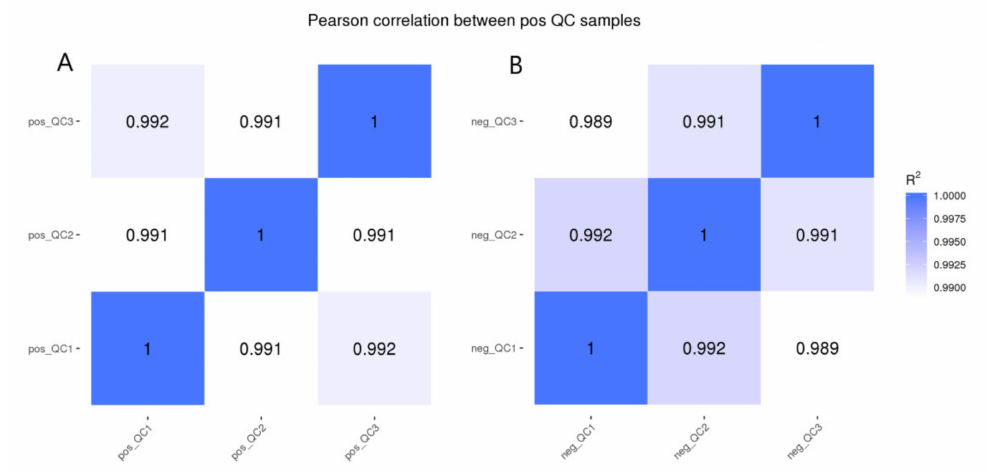
Figure 8. QC sample correlation score. ( A ) is the QC sample correlation analysis results of positive metabolites, ( B ) is the QC sample correlation analysis results of negative metabolites.